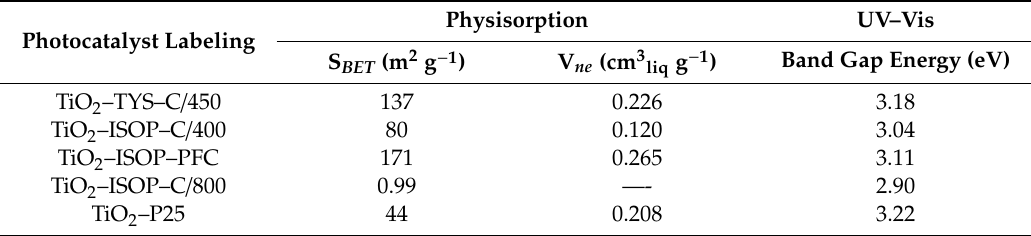
Table 1. Textural properties of investigated TiO 2